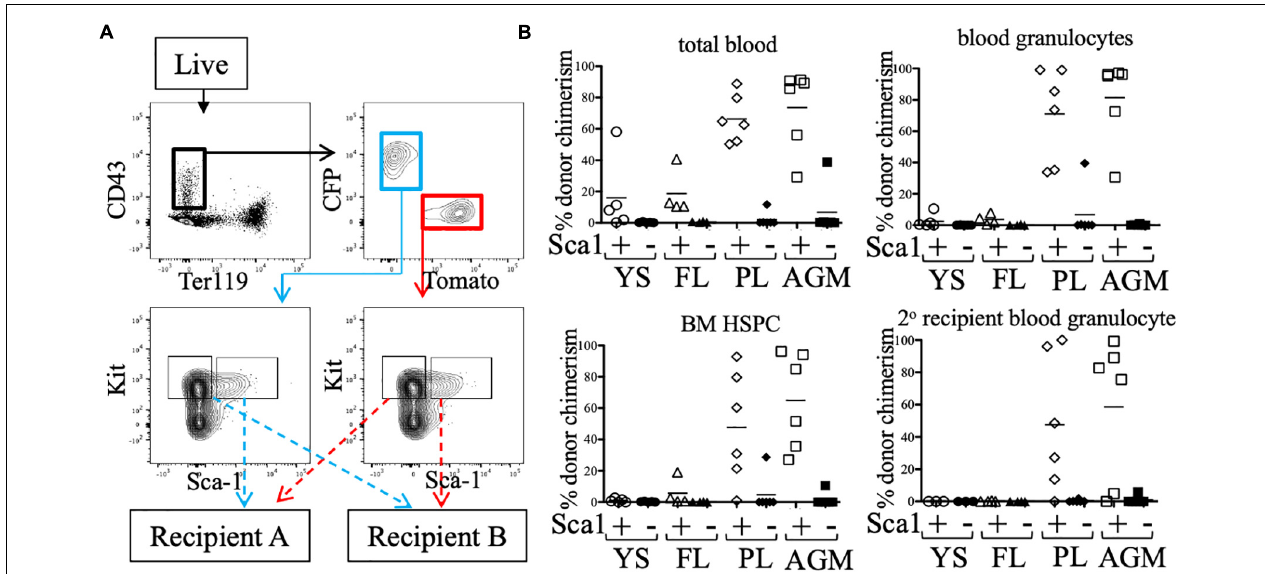
FIGURE 3 | Sca1 “plus/minus” sort and neonatal transplant. (A) Representative FACS plot of sorted populations for transplantation (AGM shown). Live cells from e11.5 embryonic tissues were first gated on CD43+ Ter119-, then separated into CFP+ and Tomato+ fractions. Kit+ cells within these gates were sorted into Sca1+ and Sca1- fractions. Prior to transplantation into neonatal NSG recipients, cells were mixed such that Sca1+ fraction of one color (e.g., CFP) was co-transplanted with the Sca1- fraction of the other color (e.g., Tomato). (B) Total blood (CD45+ cells), blood granulocyte, and BM HSPC chimerism of the Sca1+ (white symbols) and Sca1- (black symbols) fractions of e11.5 embryos are shown at week 12. Week 12 bone marrow was harvested and transplanted into lethally-irradiated B6 adult recipients and blood granulocyte chimerism was analyzed 6 weeks post-secondary